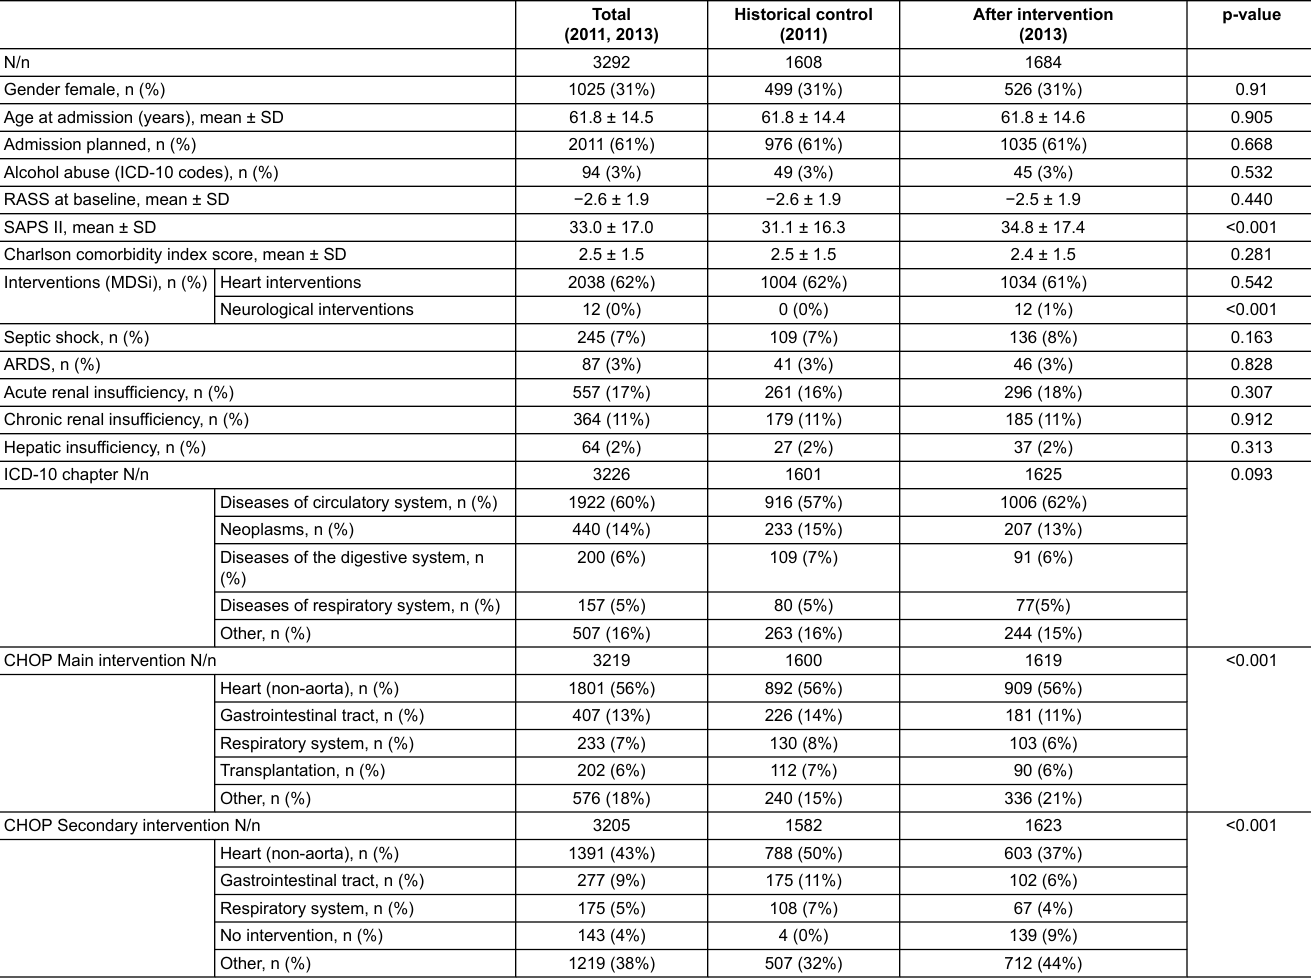
Table 1: Baseline characteristics of the historical control group and postintervention